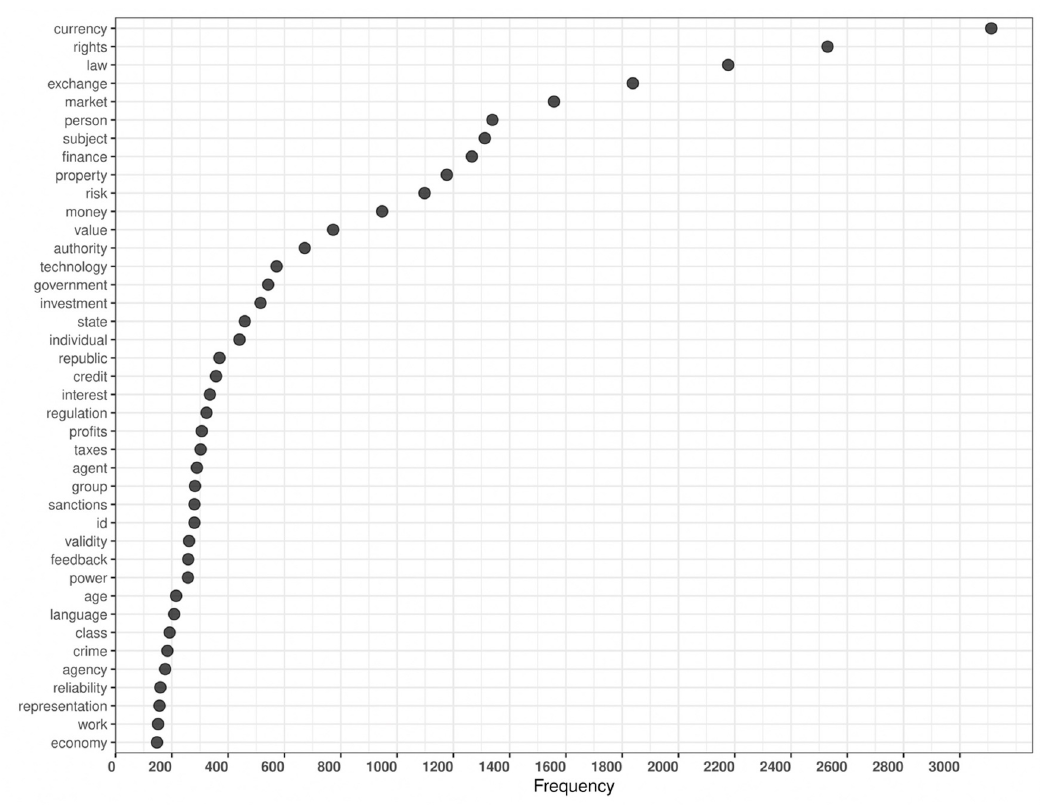
Figure 5: Frequency of Social Science Concepts in Terms of Service